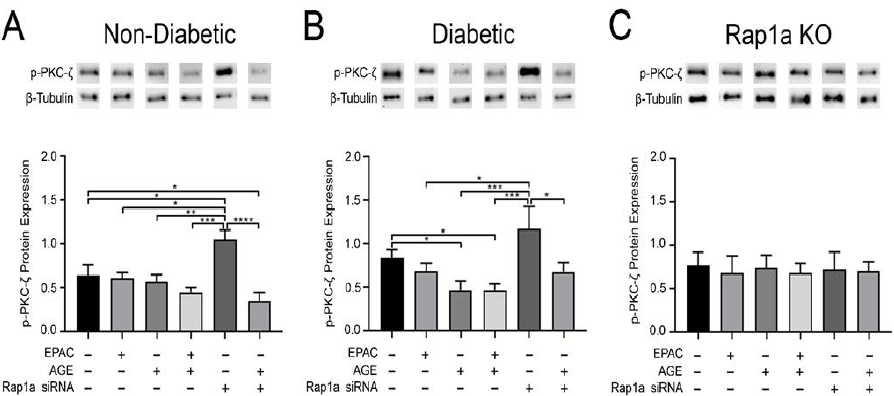
Figure 8. Rap1a modified p-PKC- ζ expression both dependently and independently of AGE/RAGE signaling. Total protein was isolated from ( A ) non-diabetic, ( B ) diabetic, and ( C ) Rap1a KO cardiac fibroblasts. Pharmacological modifiers EPAC (100 µM), exogenous AGEs (0.5 mg/mL), and Rap1a siRNA (100 nM) were added to fibroblasts either solo or in combination. p-PKC-ζ (72 kDa) protein expression was normalized to β-tubulin (55 kDa) protein expression. Representative western blot images are shown above graphs but are not displayed as a continuous blot due to running order on the blot not aligning with graphical order of samples. However, original western blot images are available at DOI:10.6084/m9.figshare.12625409. Mean ± SEM are displayed in the graphs (n = 5–10) and significance was determined with a one-way ANOVA followed by a Fisher’s protected least significant difference post hoc (* p < 0.05, ** p < 0.01, *** p < 0.001, **** p <